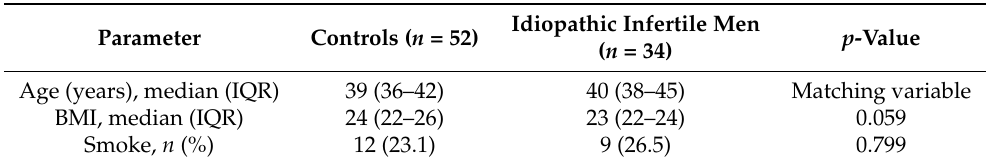
Table 1. Clinical characteristics of 34 idiopathic infertile men and 52 age-matched normo- zoospermic controls.